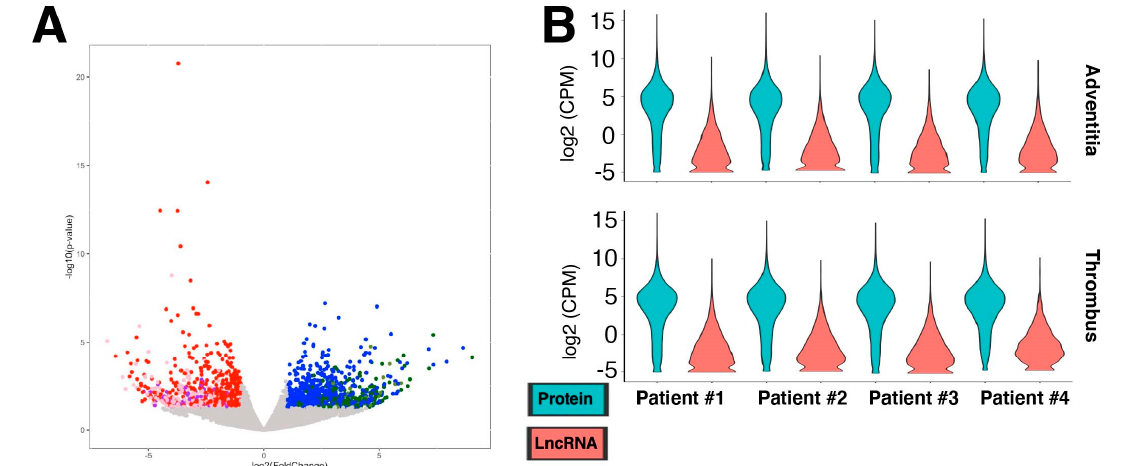
Figure 2. Differential gene expression in fibroblasts from chronic thromboembolic pulmonary hypertension (CTEPH) patients. ( A ) Volcano plot of all genes, including protein-coding and lncRNA genes. The up-regulated protein-coding genes are shown in blue, lncRNA genes in dark green, and other RNA species (based on biotypes provided by the Ensembl database) in olive. The down-regulated protein-coding genes are shown in red, lncRNA genes in pink, and other RNA in purple. With the threshold values of 2-fold and p < 0.05, there are 913 up- and 712 down-regulated genes in thrombus compared to pulmonary artery adventitia (control) of CTEPH patients ( n = 4 biological replicates). ( B ) Violin plots of RNA-seq data of fibroblasts from all four CTEPH patients. The isolation sources of fibroblasts (adventitia and thrombus) are plotted separately as indicated above.